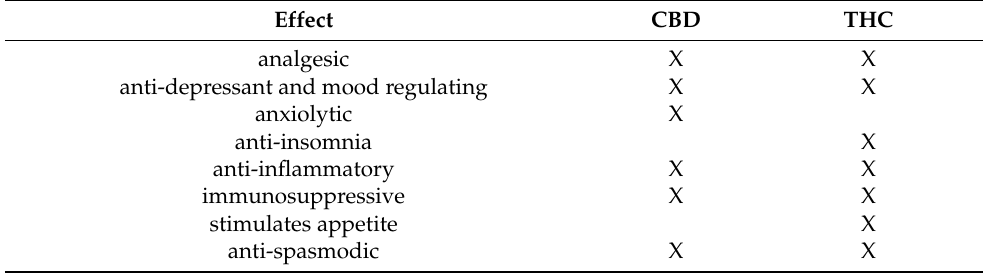
Table 1. Effects of CBD and THC